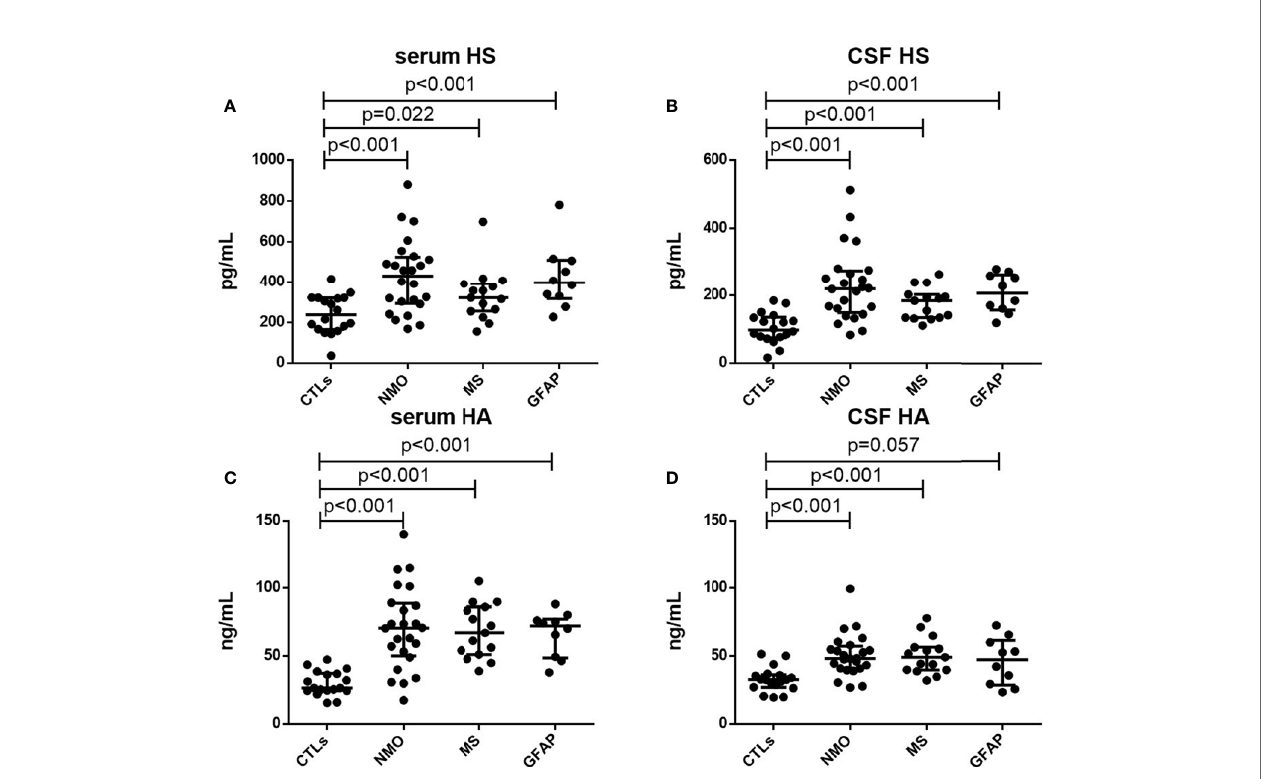
FIGURE 1 | Serum and CSF levels of HS and HA. Serum levels of HS (A) and HA (C) in controls (CTLs) and patients with NMO, MS and autoimmune GFAP astrocytopathy. CFS levels of HS (B) and HA (D) in controls (CTLs) and patients with NMO, MS and autoimmune GFAP astrocytopathy. p-values are indicated within each